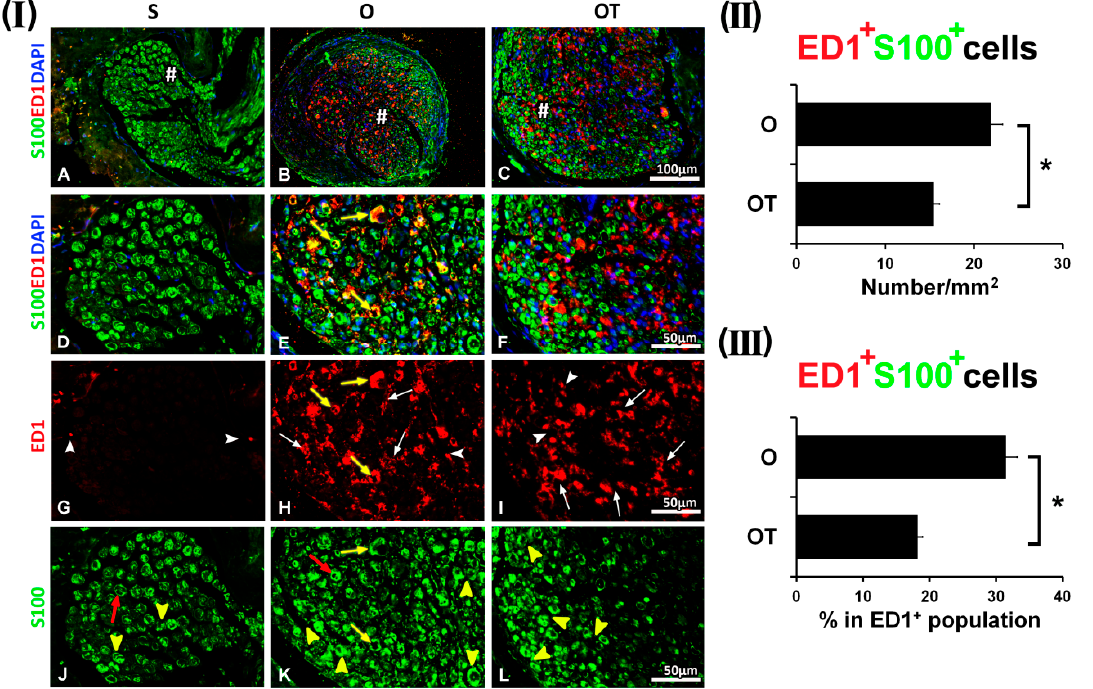
Figure 4. Effect of PNI and the treatment with B vitamins on SCs-macrophages co-localization at the 14th dpo. ( I ) ED1 (red), a common marker of activated macrophages, anti-S100 antibody (green), a marker of SCs and DAPI (blue) for visualizing cell nuclei, were used for immunostaining of the femoral nerve cross sections of the sham (S), operated (O, the transection of the motor branch) and operated and treated with the vitamin B complex (B1, B2, B3, B5, B6, and B12) (OT) groups. Almost no ED1 + cells were detected ( G , white arrow heads) in the S group. Apart from myelinating SCs ( J , yellow arrow heads), some S100 + SCs of the non-myelinating morphology ( J , red arrows) were seen as well. There was no overlapping of ED1 and S100 immunoreactivity (A, D). ED1 + macrophages with the M2-type morphology were predominant in the both O and OT groups ( H and I , white arrows), while S100 + SCs mostly belong to myelin-forming SCs ( K and L , yellow arrow heads). ED1 + /S100 + cells ( E , yellow arrows) were detected only in the O group. ED1 + macrophages of the M2-type morphology were associated ( E , yellow arrows) to the S100 + non-myelinating SCs ( K , red arrow) and some myelinating SCs ( K , yellow arrows). Minor overlapping of ED1 and S100 immunoreactivity ( C , F ) was obtained in the OT group. # indicates where the high magnification micrographs were taken from. Scale bars: A – C = 100 µm, D – L = 50 µm. ( II ) The quantification of double positive ED1 + /S100 + cells from the O and OT experimental groups was depicted in the graphs (black bars) as a number of double positive cells/mm 2 and ( III ) the percentage of double positive cells in the ED1 + cells population. The data are shown as the mean ± SEM of three independent experiments (three images/group/independent experiment were captured). Statistical analysis was done using a two-sided Student’s t-test (* p < 0.05 vs. O group, as indicated at the graphs).